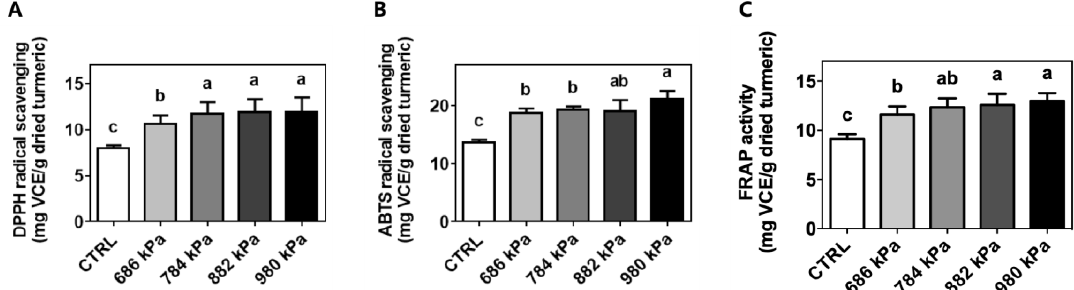
Figure 3. Enhanced antioxidant capacity of turmeric extract using puffing. Means with different letters (a–c) were statistically significant at p < 0.05 within the identified radical-scavenging assay ( n